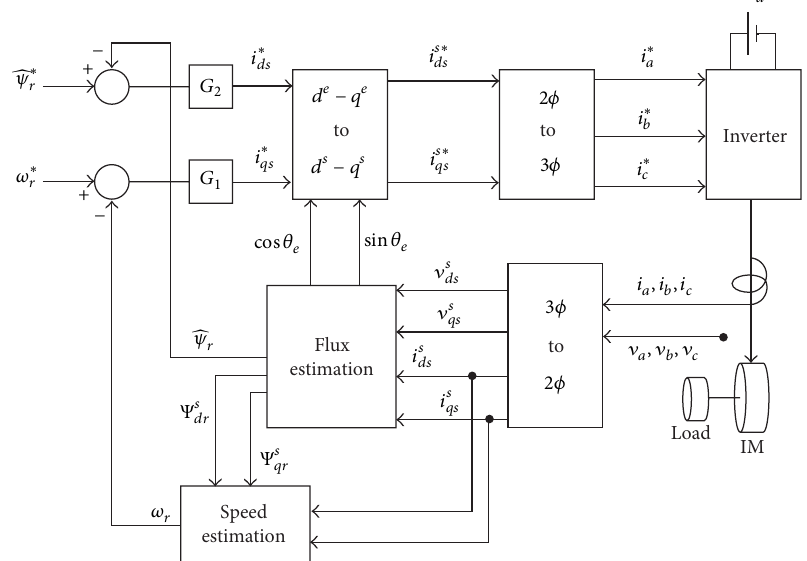
Figure 2: Block diagram of sensor less vector control for three-phase IM drive.